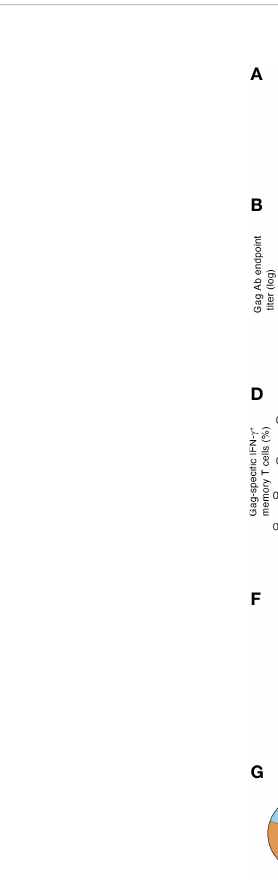
FIGURE 2 High dose mRNA/LNP vaccination increased cellular but not humoral responses. (A) Schematic representation of the high-dose (100 m g) gag mRNA/LNP vaccination regimen administered in two vaccinations (V1, V2; brown symbols). The data were compared to the low dose (25 m g) regimen described in Figure 1 (group 2; green symbols). (B) Vaccine-induced Gag Ab titers were plotted over time as reciprocal endpoint titers (log) from macaques immunized with the high dose mRNA/LNP vaccine. (C) Comparison of Gag Ab titers from the high and low dose mRNA/ LNP regimens at two weeks after the 2 nd vaccination. (D, E) The antigen-speci fi c cellular analysis was performed by fl ow cytometry at 2 weeks after the 2 nd vaccination. (D) Plot showing the Gag-speci fi c CD4 + and CD8 + memory (CD3 + CD95 + IFN- g + ) T cell responses measured in PBMC. (E) Plot comparing the Gag-speci fi c T cell responses as % of total T cells in macaques immunized twice with low dose (25 m g; described in Figure 1) and high dose (100 m g) mRNA/LNP vaccines, respectively. Responses in macaques immunized twice with 1 mg gag DNA (grey symbols) are included. The DNA vaccine contained IL-12 DNA as vaccine adjuvant and was administered by IM injection followed by electroporation. The p value is from t test (Mann-Whitney). (F-G) Analysis of gag mRNA/LNP vaccine induced memory CD4 immune responses. (F) Gating strategy for unstimulated and Gag peptide stimulated memory T cells producing IFN- g and TNF a . (G) Pie charts showing responses of the 4 animals in the high dose vaccine